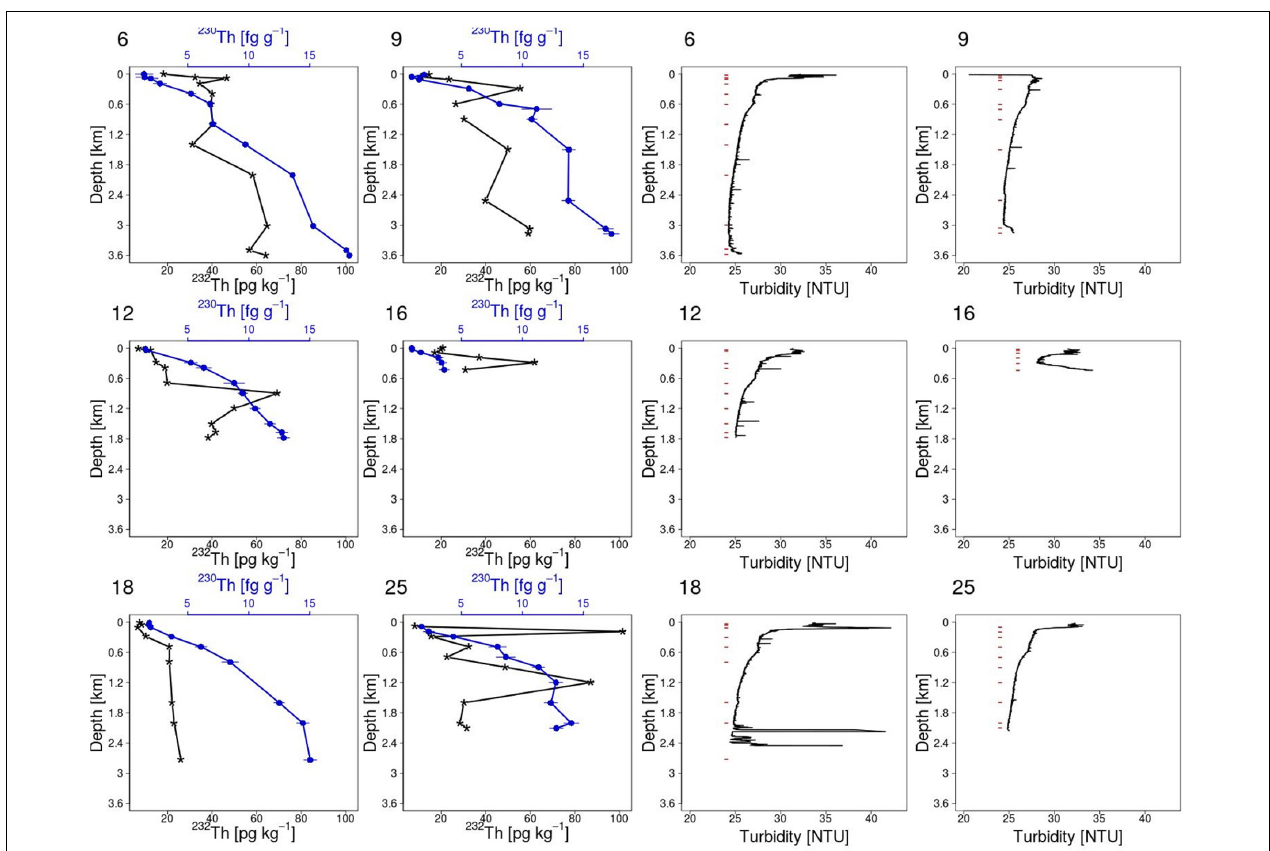
FIGURE 5 | 232 Th (stars) and 230 Th xs (blue circles) concentration profiles for HEOBI stations in the left panel and on the right one the turbidity profiles at each station. Note that the deepest sample of each profile was collected ∼ 10 m above the bottom. Red lines on the right panel represent the depth at which Th samples were